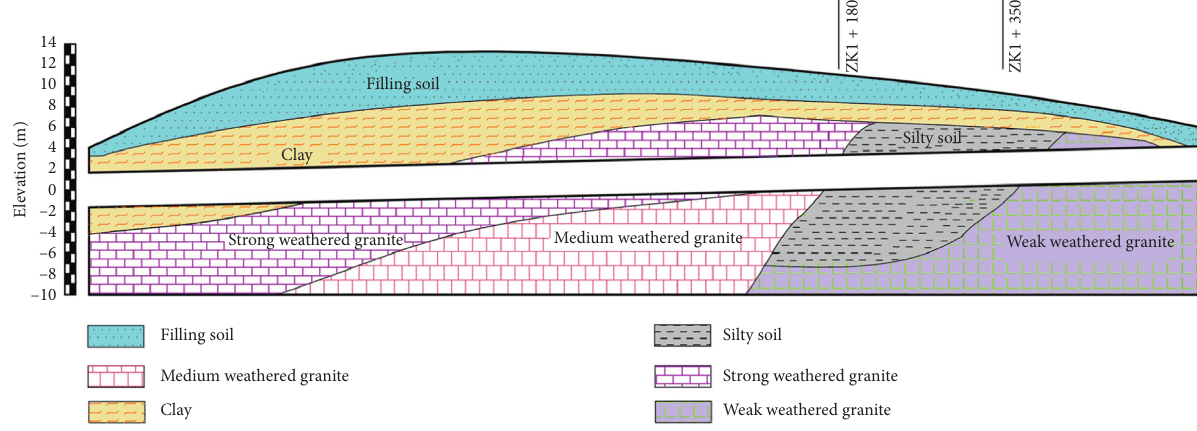
Figure 3: Longitudinal section of the left tunnel.